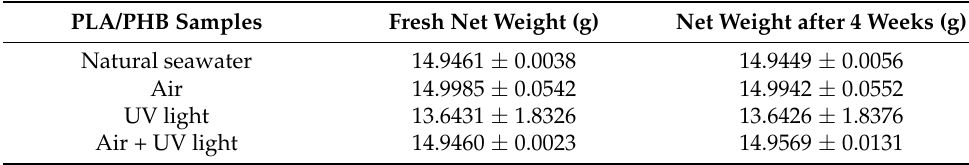
Table 1. Results of the mass weights of PLA/PHB plastics before and after four weeks’ immersion under various environmental conditions.